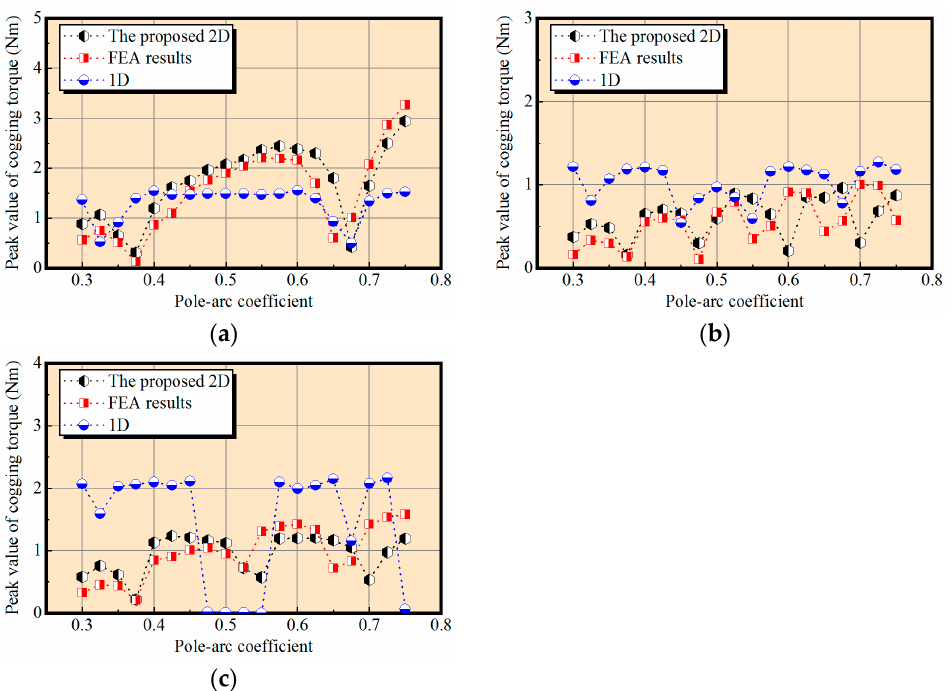
Figure 14. Cogging torque peak value trends with varying pole-arc coefficient, when slot-opening coefficient α s = 0.18: ( a ) 8P12S. ( b ) 8P36S. ( c ) 8P48S.